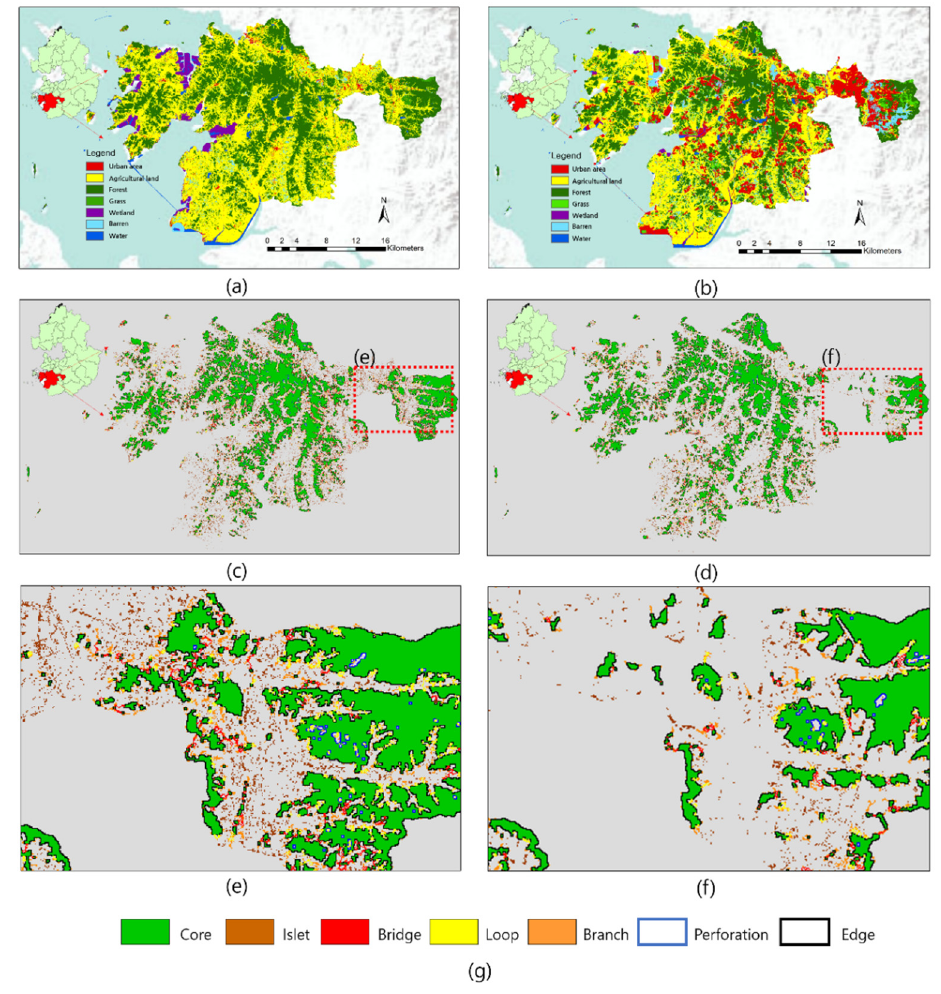
Figure 6. ( a ) 1988 land cover map of Hwaseong, ( b ) 2018 land cover map of Hwaseong, ( c ) 1988 MSPA map of Hwaseong ( d ) 2018 MSPA map of Hwaseong, ( e ) detailed view of map ( c ), ( f ) detailed view of map ( d ), and ( g ) legend of MSPA categories.